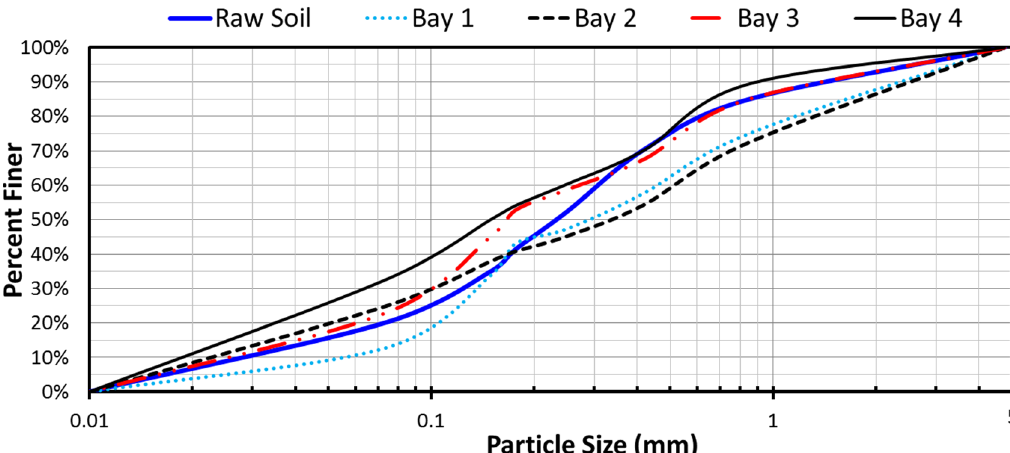
Figure 6. Particle-size distributions of raw soil at the construction site of the basin, deposited sediments in Bay 1, Bay 2, Bay 3, and Bay 4 of the basin at the end of data